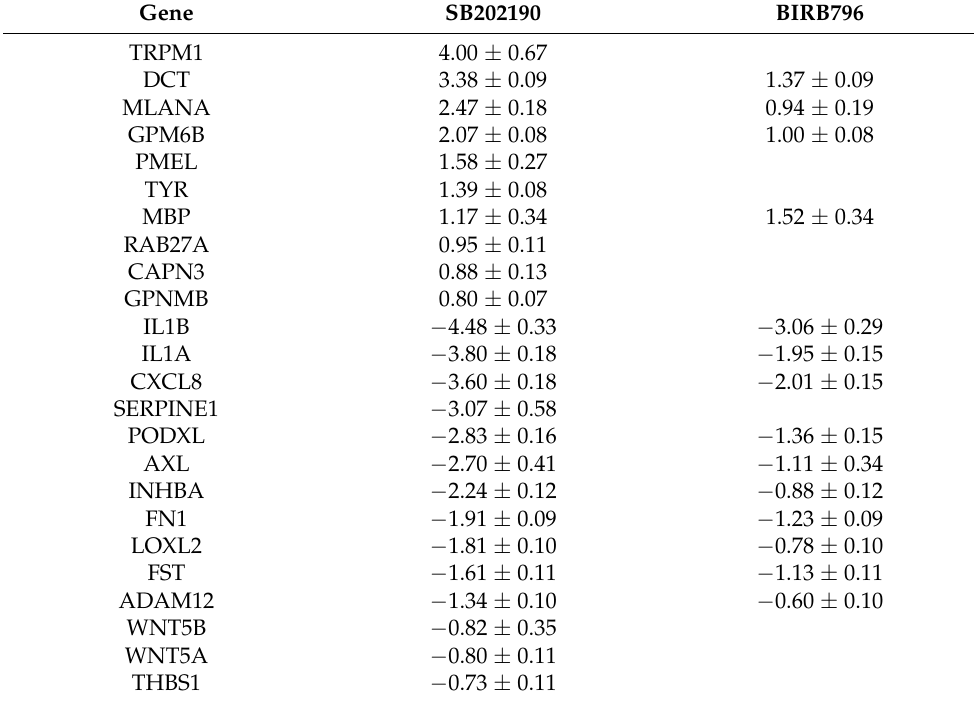
Table 2. Changes in expression of melanoma phenotype-related genes detected with RNA-seq. Average log2 fold change values ± standard error as obtained with DESeq2.